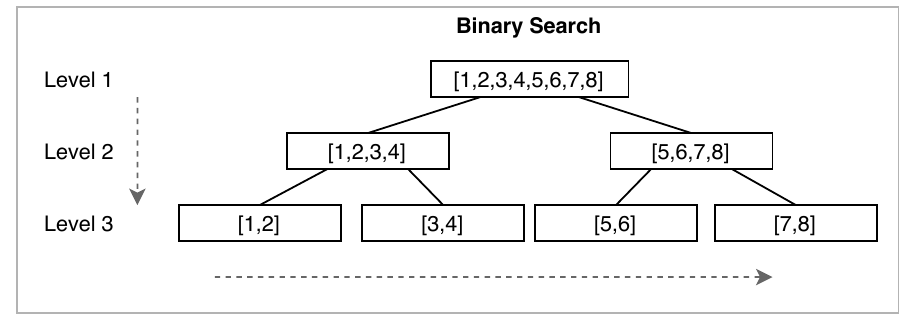
Figure 1. How the binary search works in the K-tuple full withholding (KTFW) when k =